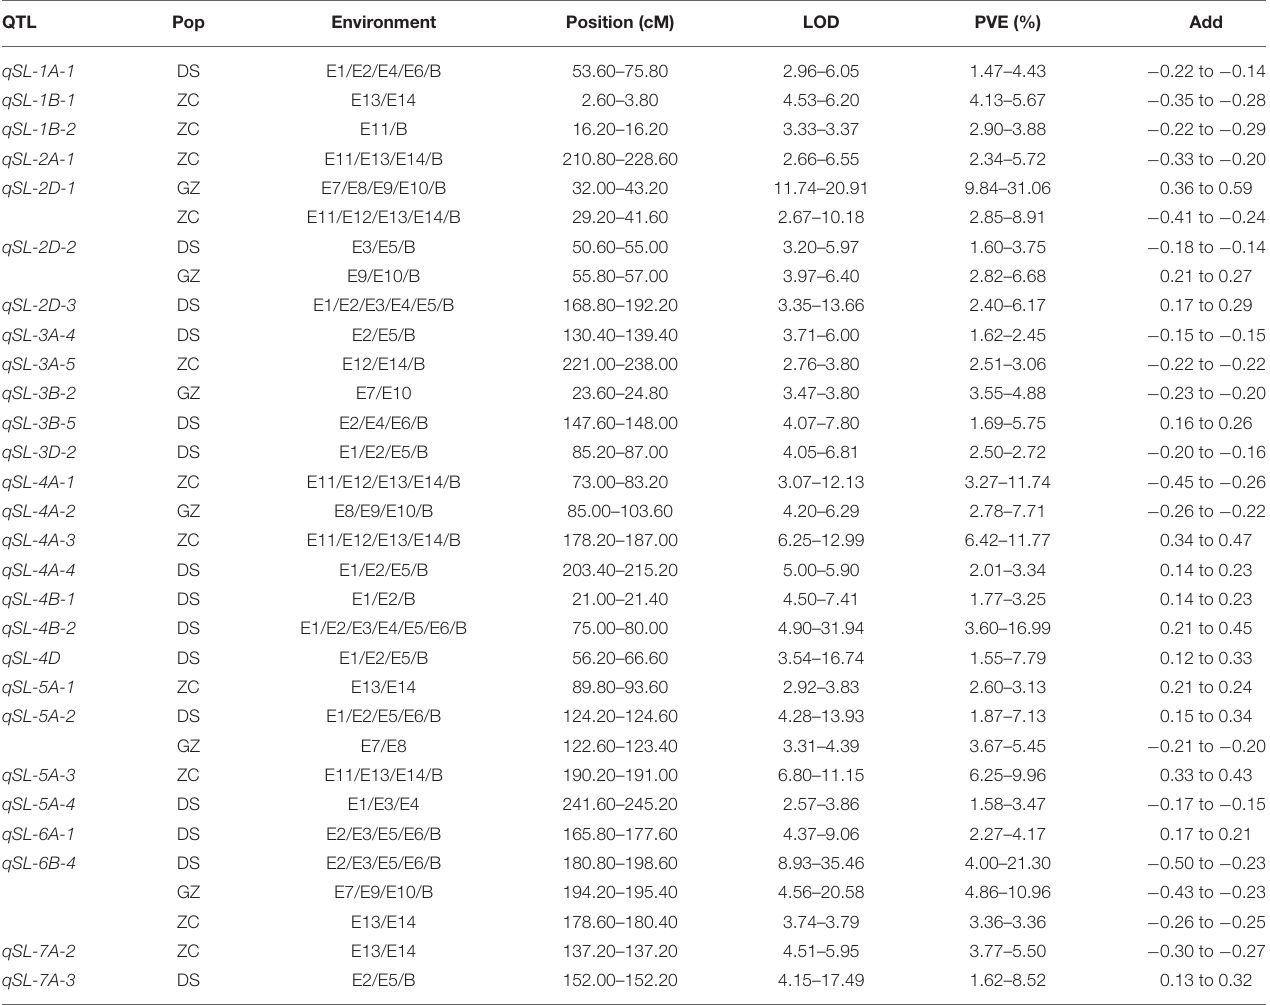
TABLE 4 | Stable QTLs identified for SL in the three RIL populations, DS, GZ, and ZC using the consensus